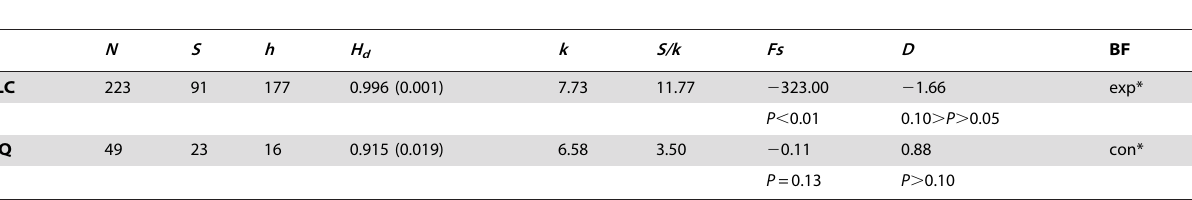
Table 1. Population genetic summary and demographic statistics for Victoria Land Coast (VLC) and Macquarie (MQ) populations.